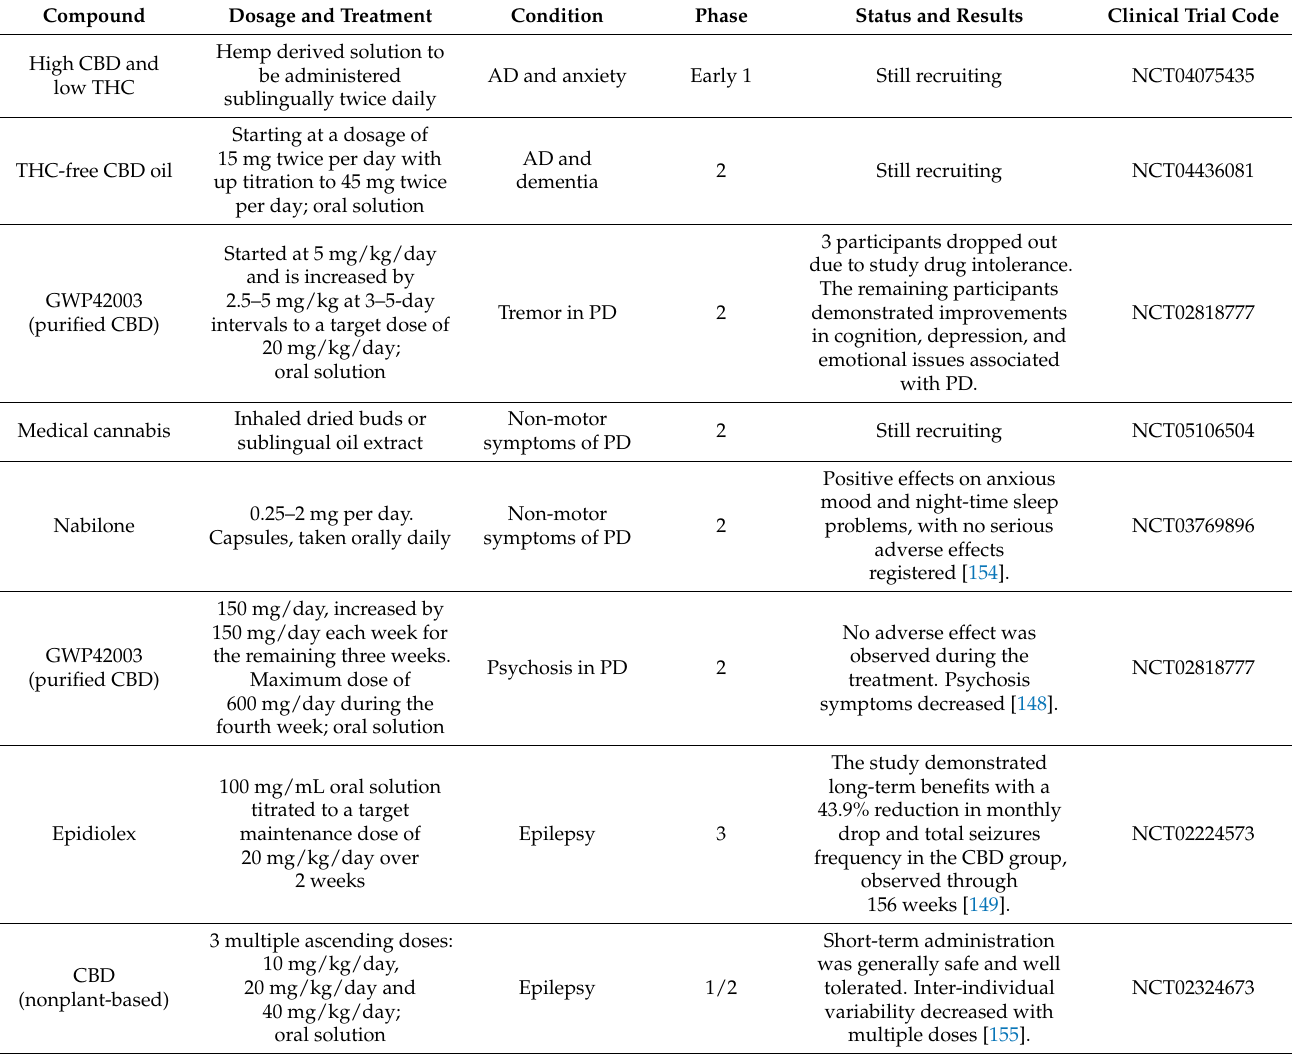
Table 2. List of clinical trials available at clinicaltrials.gov for the use of CBD in neurologic